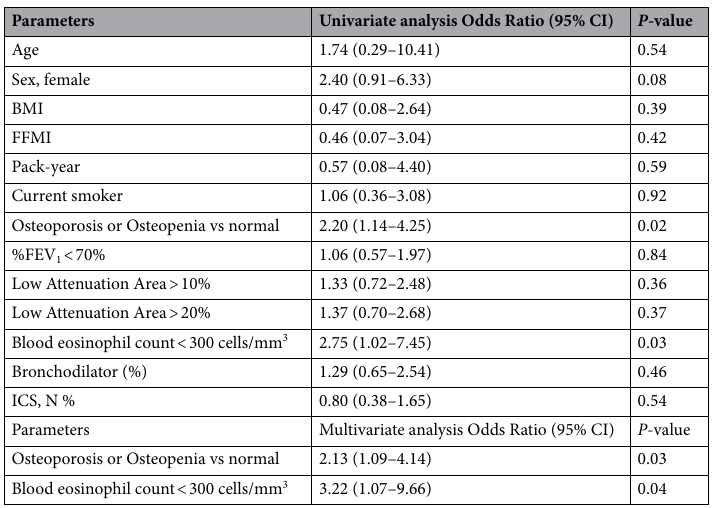
Table 4. Predictors of LAA% rapid progression by univariate and multivariate logistic regression analysis. BMI body mass index, CI confidence interval, FFMI fat-free mass index, %FEV 1 forced expiratory volume in 1 s as a percentage of predicted forced expiratory volume in 1 s, LAA% the ratio of low attenuation area to total lung volume, ICS inhaled